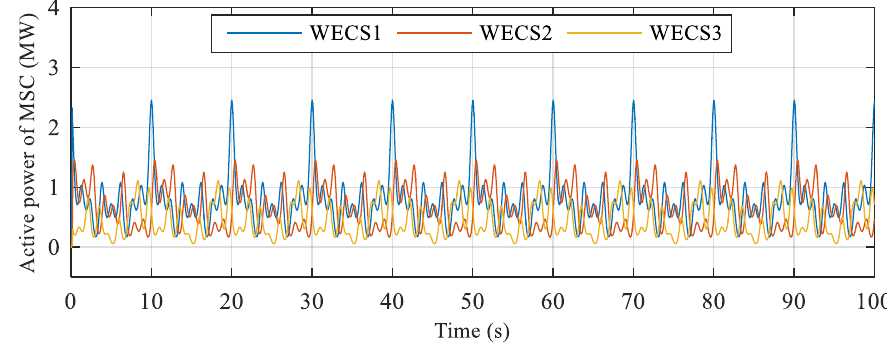
Figure 6. Active power of machine-side converter.